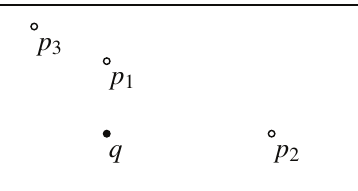
Fig. 1. Example Road